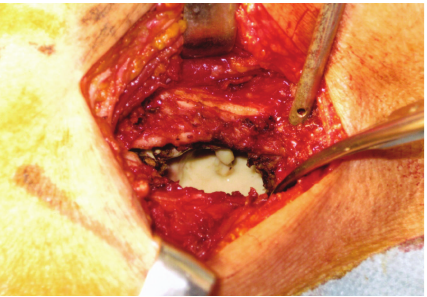
Figure 4: Operative findings in Case 3. The destroyed lung parenchyma and abscess wall were lumped into a mass of fibrous tissue. The cavity contained whitish purulent contents and an irregular-shaped fibrous mass associated with an